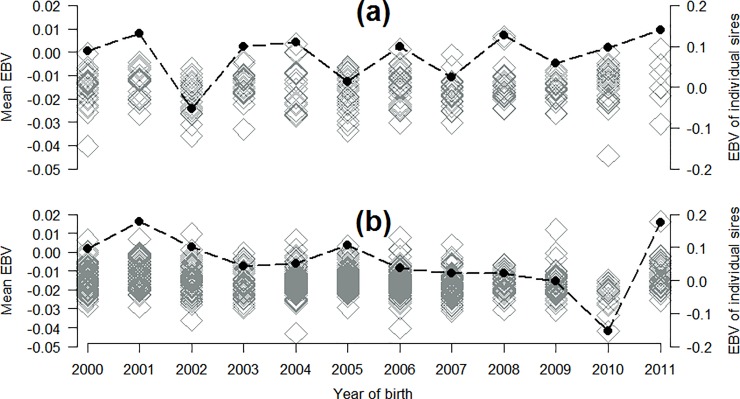
Distribution of the mean sire EBV (primary axis; line) and individual sire EBV (secondary axis; diamond) per year of birth for a) 243 beef AI sires and b) 799 dairy AI sires that had ≥ 20 progeny with a bovine tuberculosis phenotype in at least 2 herds.